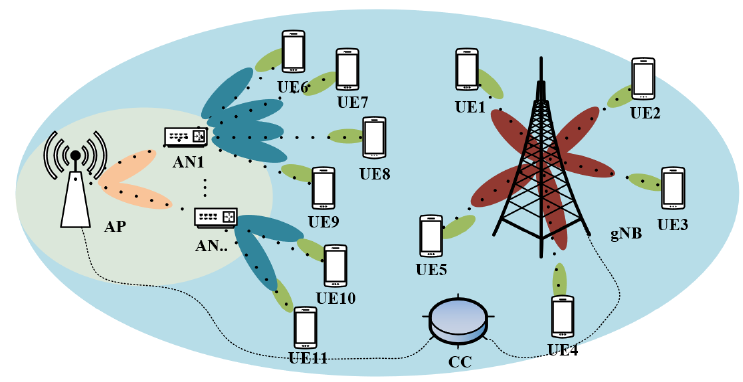
Figure 1. Cellular–Wi-Fi heterogeneous network